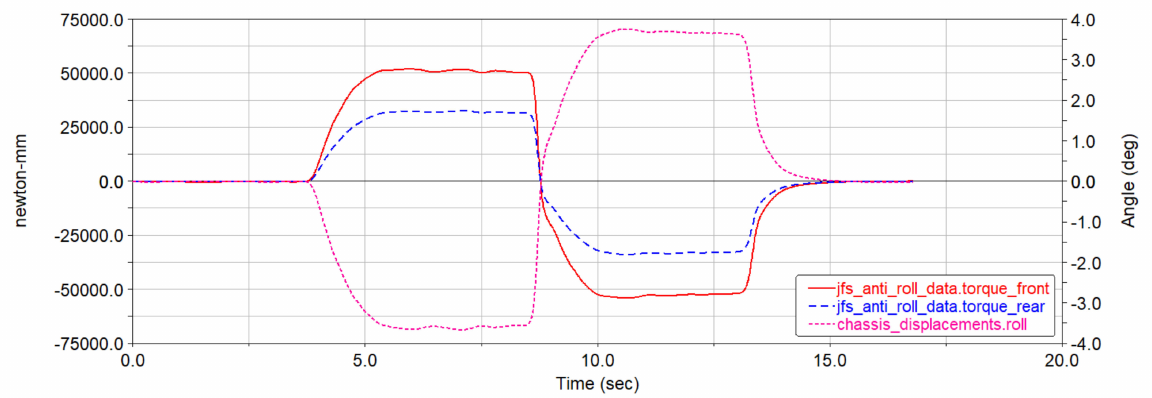
Figure 18. Skidpad Event-Roll, baseline set-up.